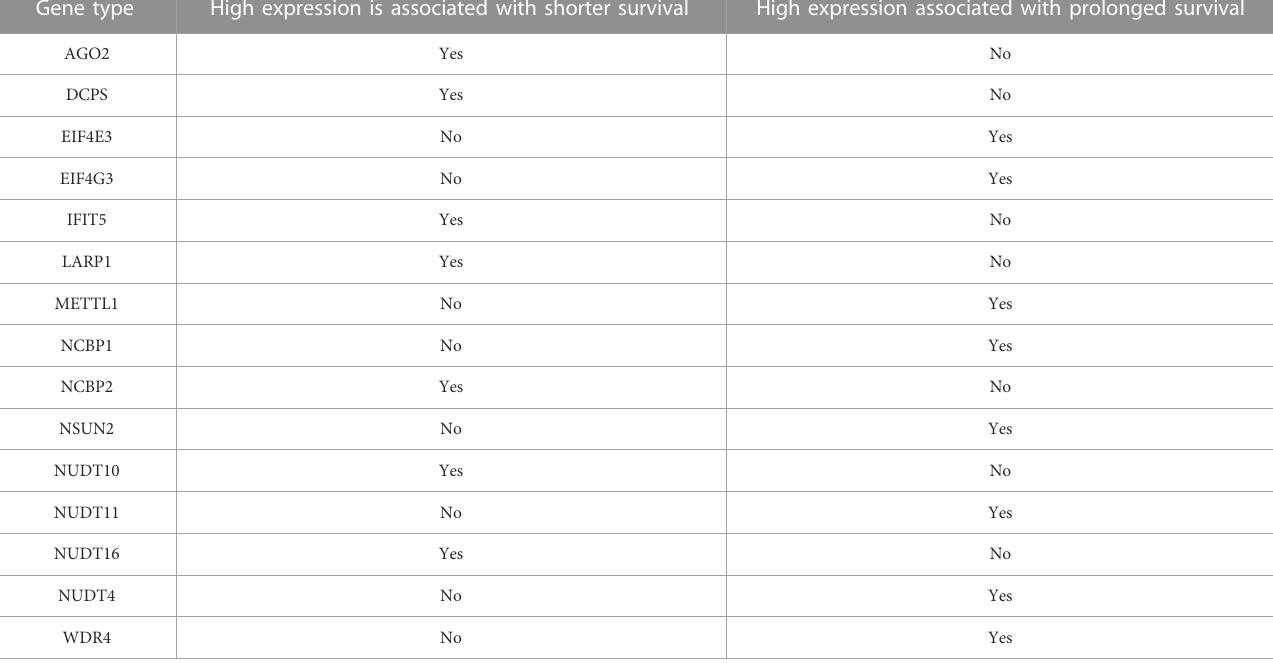
TABLE 4 Prognostic value of liver cancer genes. Gene